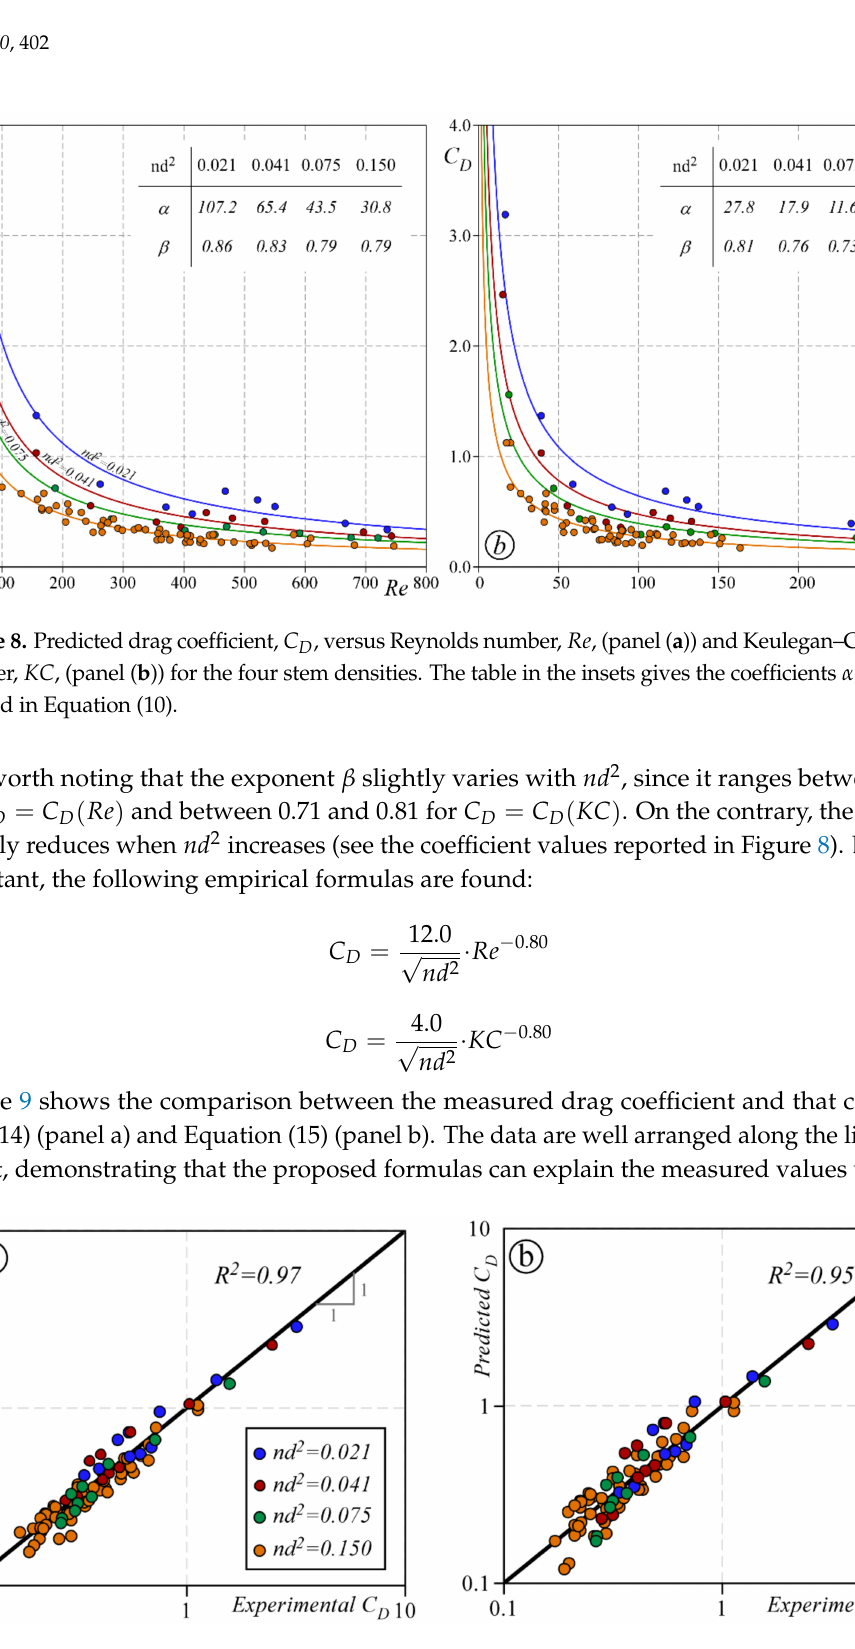
Figure 9. Predicted versus experimental drag coefficient, C D ; given by Equation (14) (panel ( a )) and by Equation (15) (panel ( b )). Solid black line indicates perfect agreement between the data and the empirical